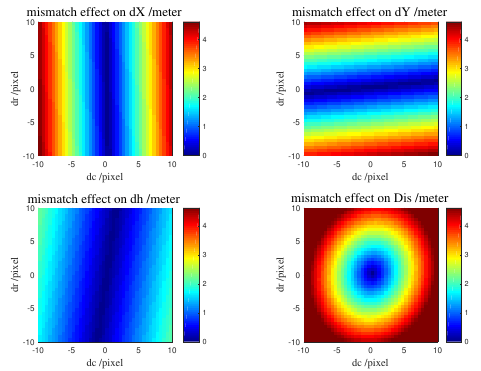
Figure 9. Illustration of the effect of mismatching a SAR keypoint in the optical image.